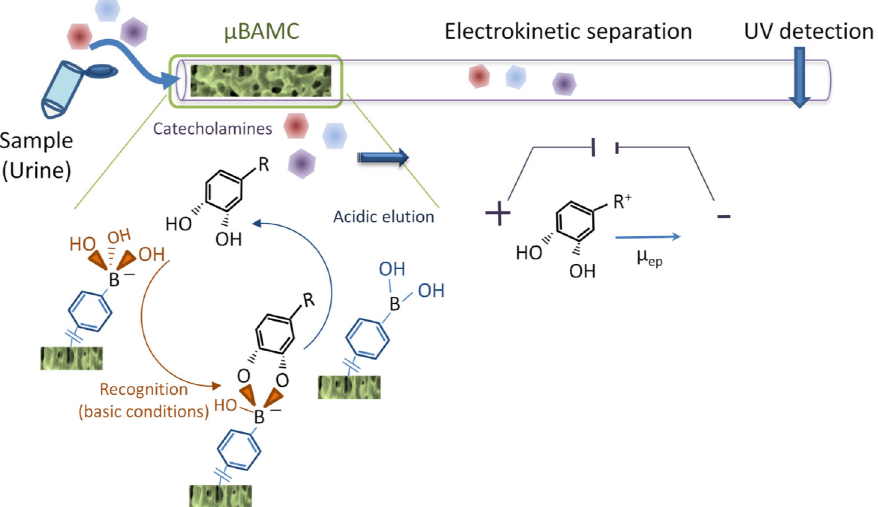
Figure 4. Schematic illustration of the different steps of cis -diols compounds analysis: preconcentra- tion and purification on the integrated µBAMC unit, acidic elution and capillary zone electropho- resis separation, and UV detection. Reprinted with permission from reference [86].